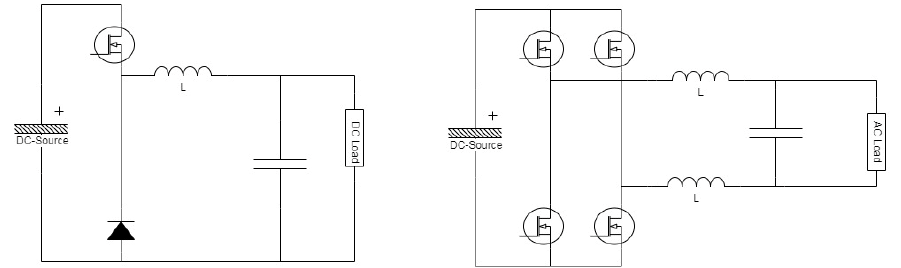
Figure 1. Classical Buck-derived converter topologies. ( Left ) a buck chopper and ( right ) a voltage source inverter. source